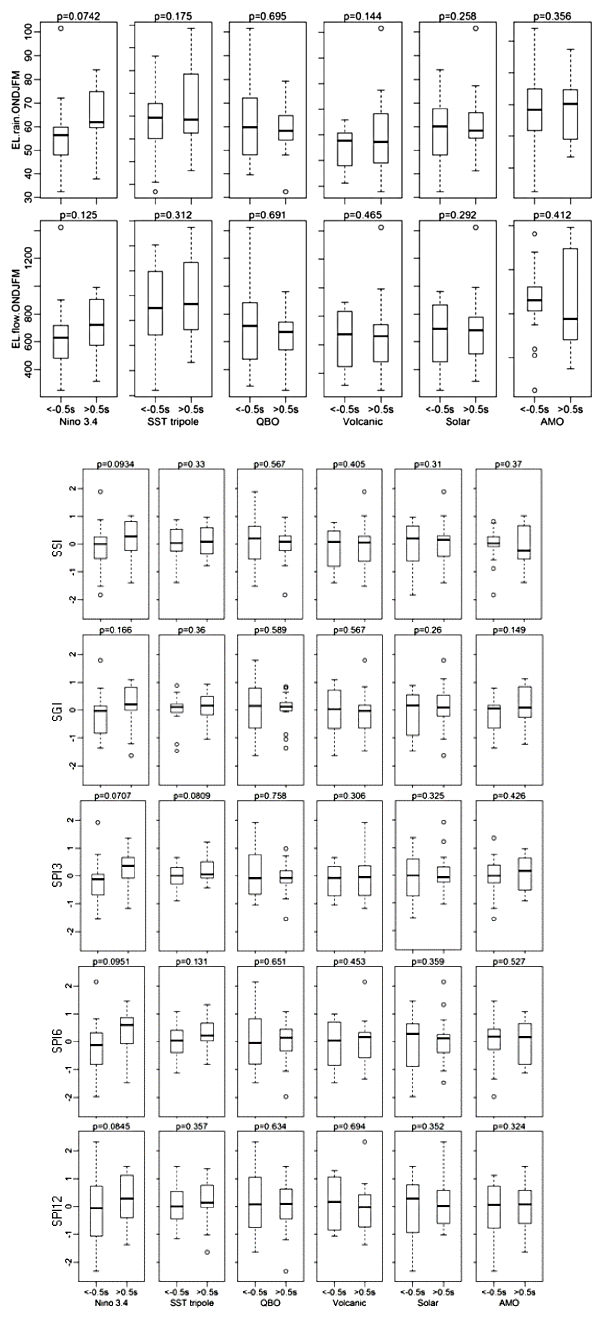
Figure 12. (a) Box plots of English Lowland response variables for the October to March winter half-year (English Lowlands areal rainfall and total flow), for low ( < − 0.5SD) and high ( > 0.5SD) values of different drivers (Niño3.4, TSI, May SST tripole, AMO, stratospheric aerosol loadings and QBO). (b) Box plots of English Lowland response variables for the October to March winter half- year (SSI flow, SGI groundwater and three accumulation periods for the SPI), for low ( < − 0.5SD) and high ( > 0.5SD) values of different